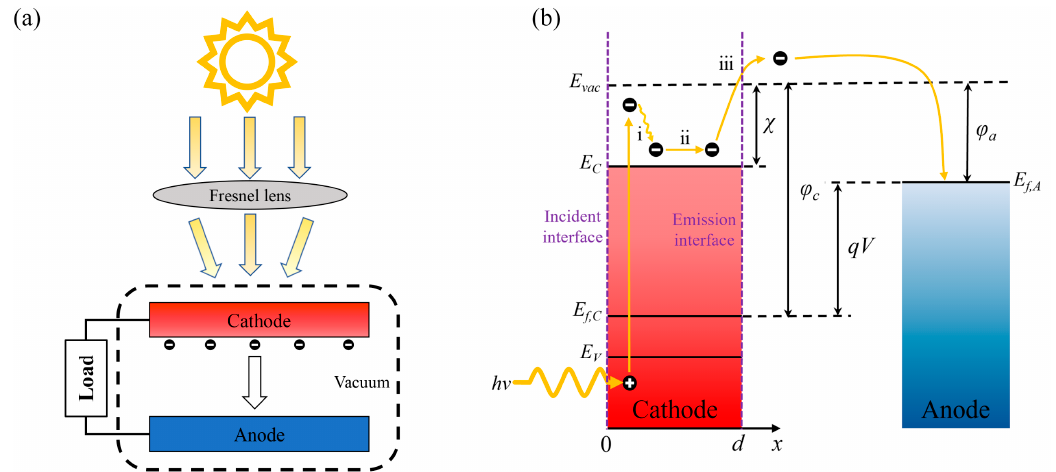
Figure 1. ( a ) Structure of the PETE solar converter and ( b ) schematic diagram of the bandgap of the PETE converter. h υ is the energy of the incident photons. E C and E V represent the conduction band minimum and valence band maximum, respectively. E f is the Fermi level of the cathode, and E vac represents the vacuum level. χ is the cathode electron affinity. ϕ c and ϕ a represent the work functions of the cathode and the anode, respectively.